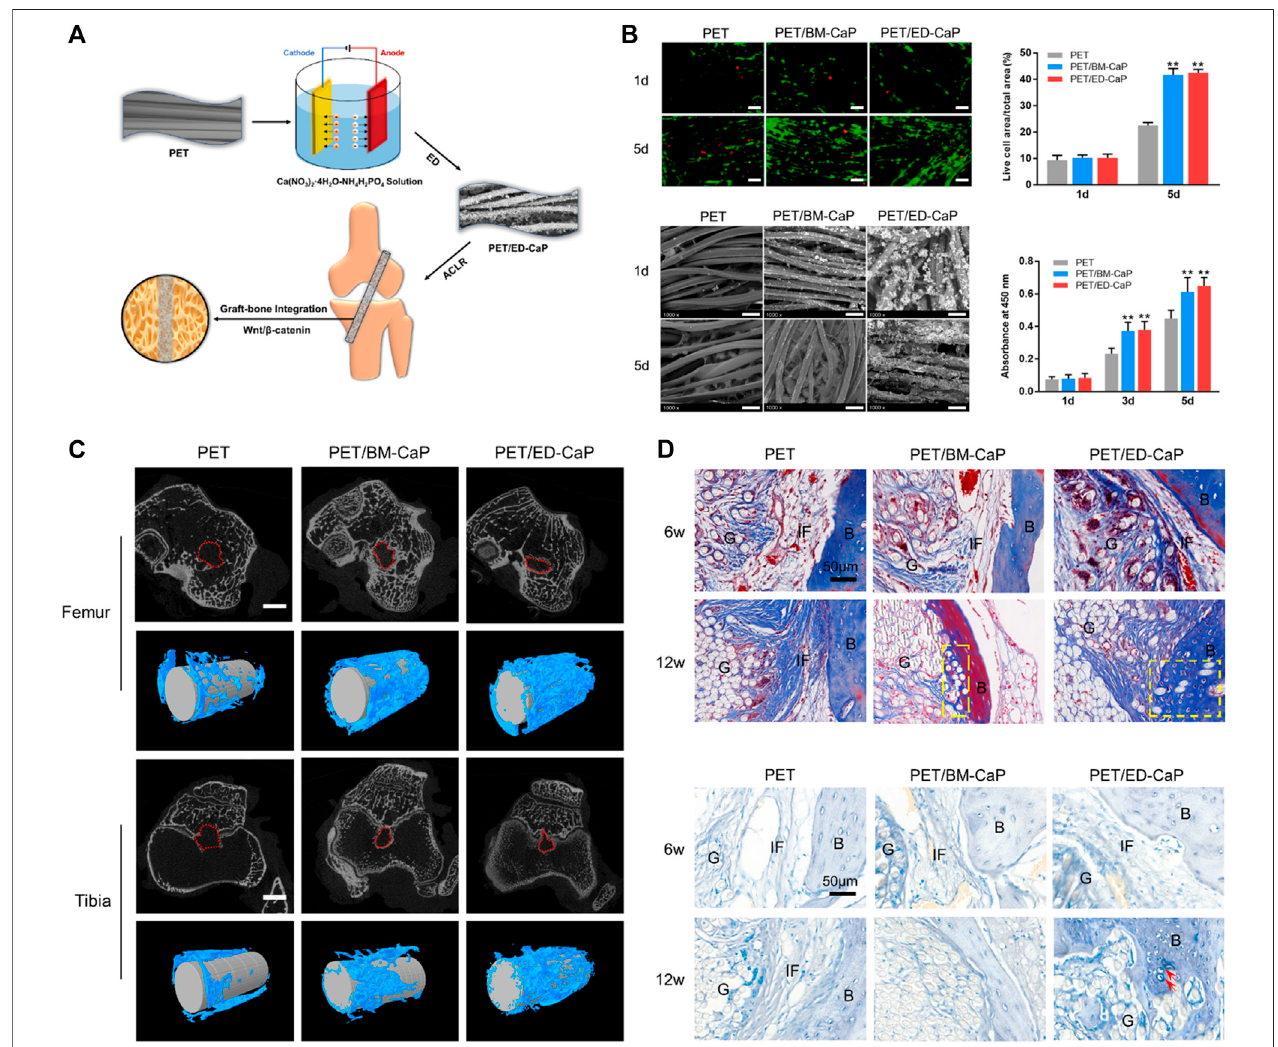
FIGURE 3 | Electrodeposition of calcium phosphate onto polyethylene terephthalate arti fi cial ligament enhances graft-bone integration after anterior cruciate ligamentreconstruction. (A) Electrodepositionofcalciumphosphate ontopolyethyleneterephthalate arti fi cialligament; (B) TheviabilityandSEMmorphologyofMC3T3- E1inthePET,PET/BM-CaPandPET/ED-CaPgroups; (C) Micro-CTanalysisofthePET,PET/BM-CaPandPET/ED-CaPgroupsat12 weeksaftersurgery; (D) Masson and toluidine blue staining results of pathological sections in the PET, PET/BM-CaP and PET/ED-CaP groups at 6 and 12 weeks after surgery. Copyright 2021